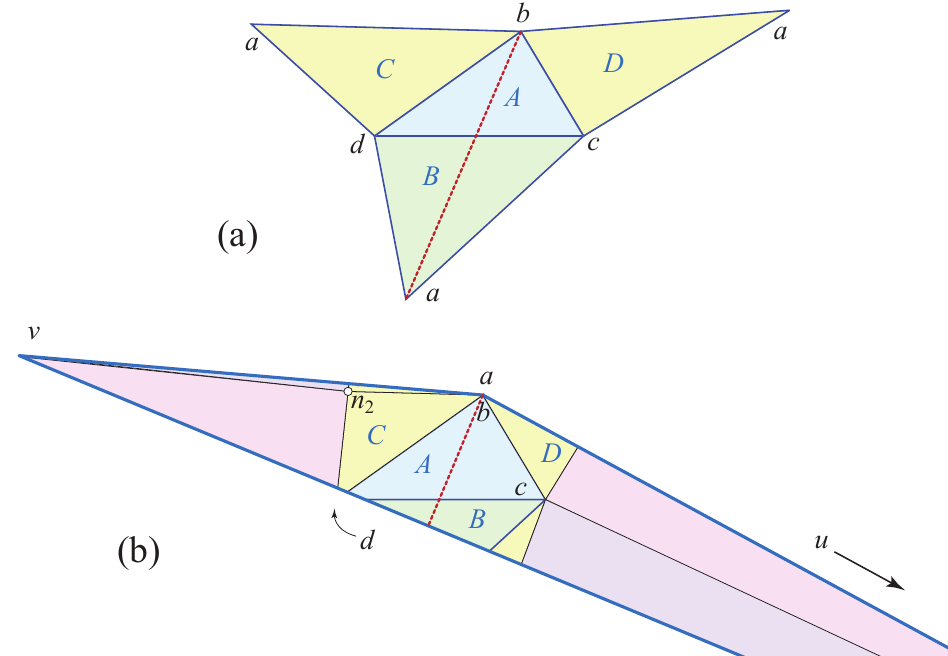
Figure 13. ( a ) Unfolding of a pointed tetrahedron, with edge-loop red. ( b ) One side of ∆ , an obtuse doubly-covered triangle with edge-loop along the altitude. ( n 1 is on the back